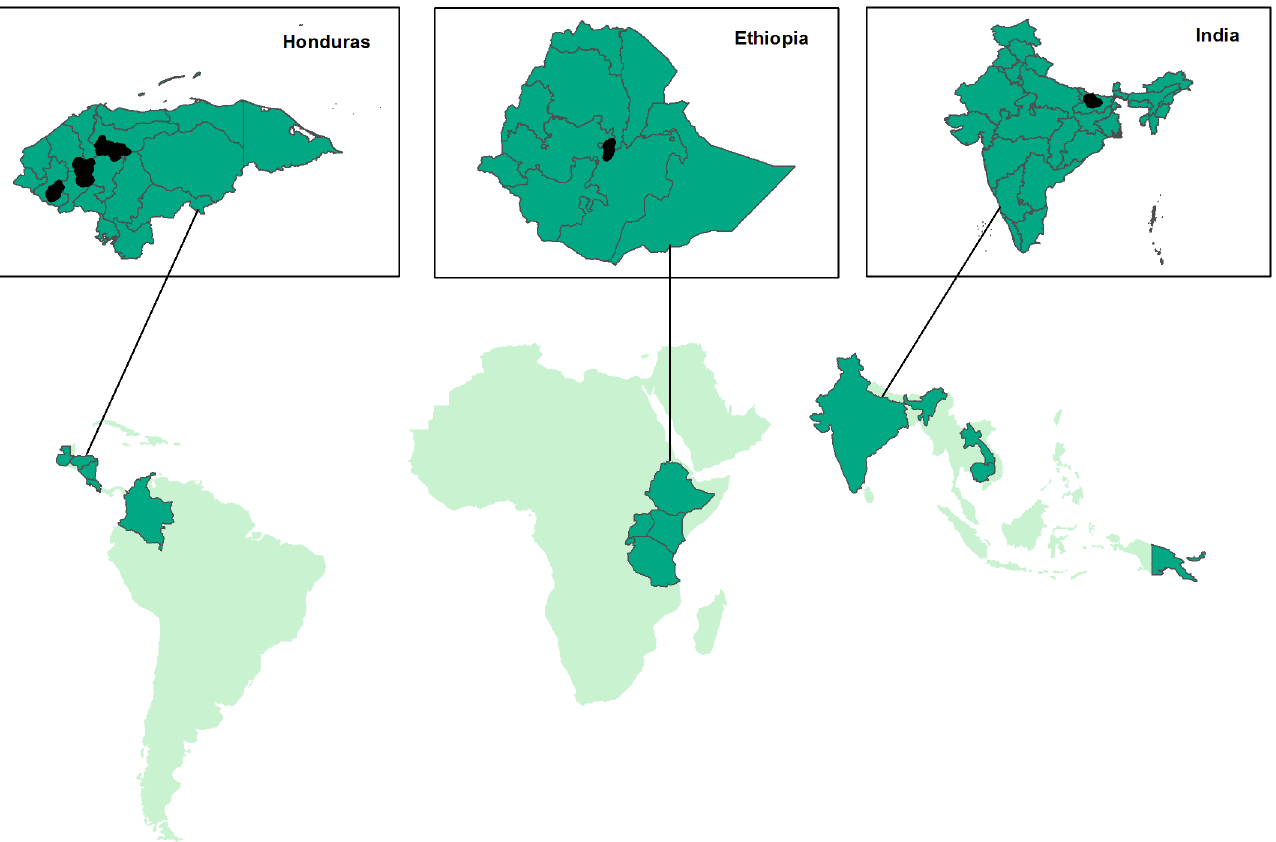
Fig 1. Overview of countries where the Seeds for Needs initiative is running (lower map) and locations in Honduras, Ethiopia and India (upper insets) where the surveyswere conducted (black polygons inside the three countries).